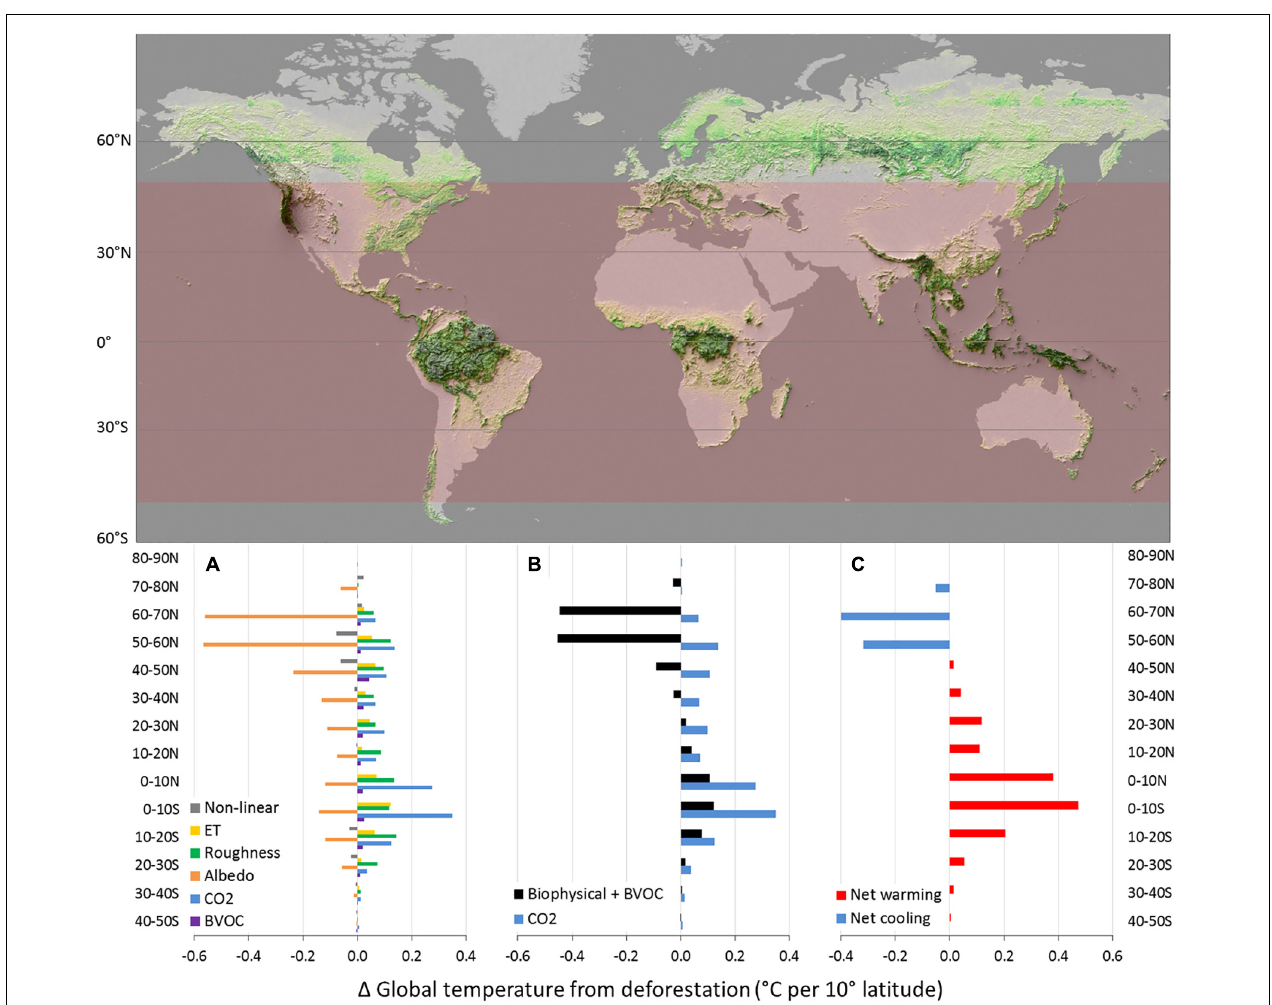
FIGURE 5 | Effect of complete deforestation on global temperature by 10 ◦ band of latitude. (A) Contribution to global temperature change by climate forcing factor. Biophysical factors are from Davin and de Noblet-Ducoudré, 2010, area-weighted. BVOC effects are estimated relative to albedo effects based on Scott et al., 2018. CO 2 effect is based on aboveground live biomass for each 10 ◦ latitudinal band following Baccini et al., 2017 and Walker et al., 2020. (B) Net biophysical and BVOC effect versus CO 2 effect. (C) Cooling or warming effects of deforestation by 10 ◦ latitudinal band (BVOC included). “Forests as mountains” map of aboveground biomass carbon in woody vegetation ca. 2016 courtesy of Woodwell Climate Research Center and shaded to indicate where deforestation results in net global warming. See Supplementary Information 1 for